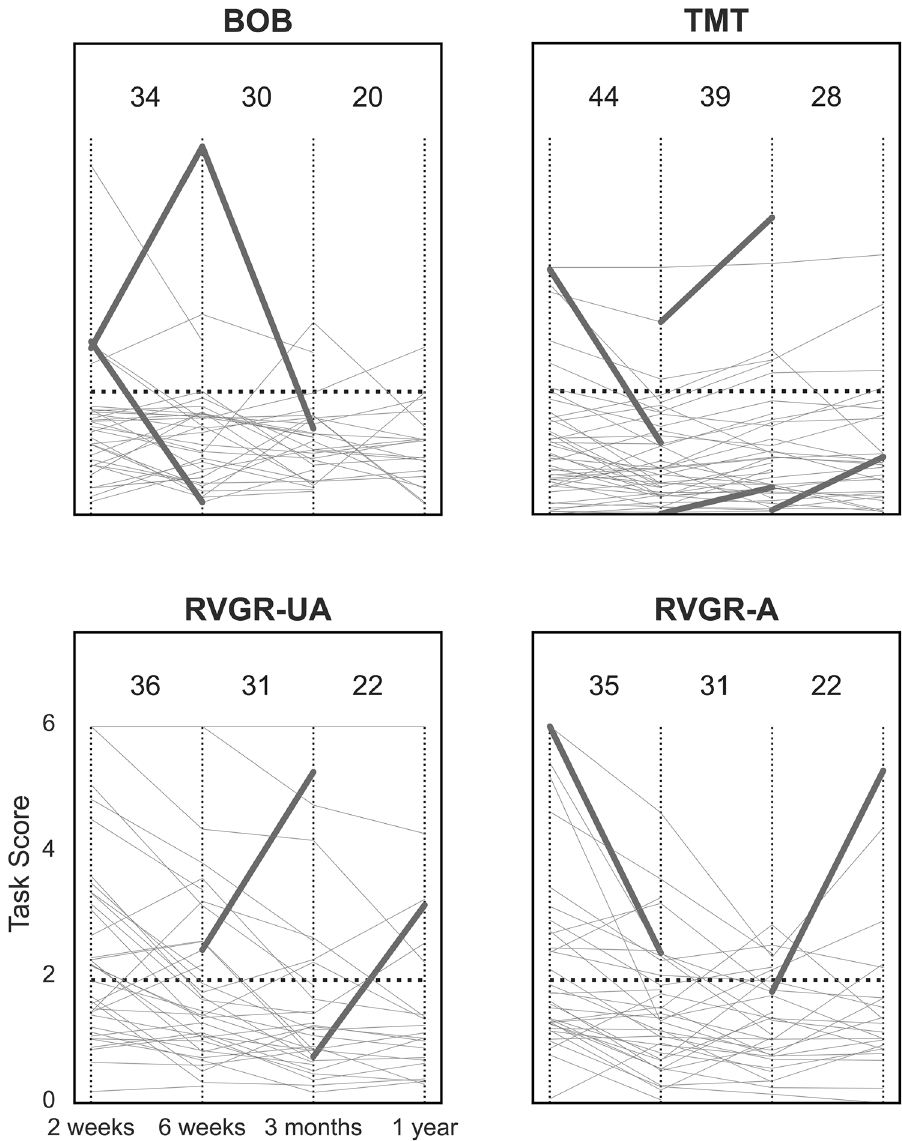
Figure 4. Line plots of task scores over time in the TIA cohort at all 4 assessments with significant changes corrected for the false discovery rate (FDR). A affected arm, UA unaffected arm. Thin vertical lines demarcate different assessment points for ease of viewing. Horizontal dashed lines represent the threshold for impairment in Task Scores (i.e., > 1.96). Thin grey lines represent each individual’s performance over time. Thick lines indicate significant improvement or deterioration between assessments. Values at the top of each plot indicate the total number of individuals plotted on the relevant interval, e.g., BOB between the first two vertical dashed lines has 34 individuals plotted, one of whom significantly improved, and one of whom significantly